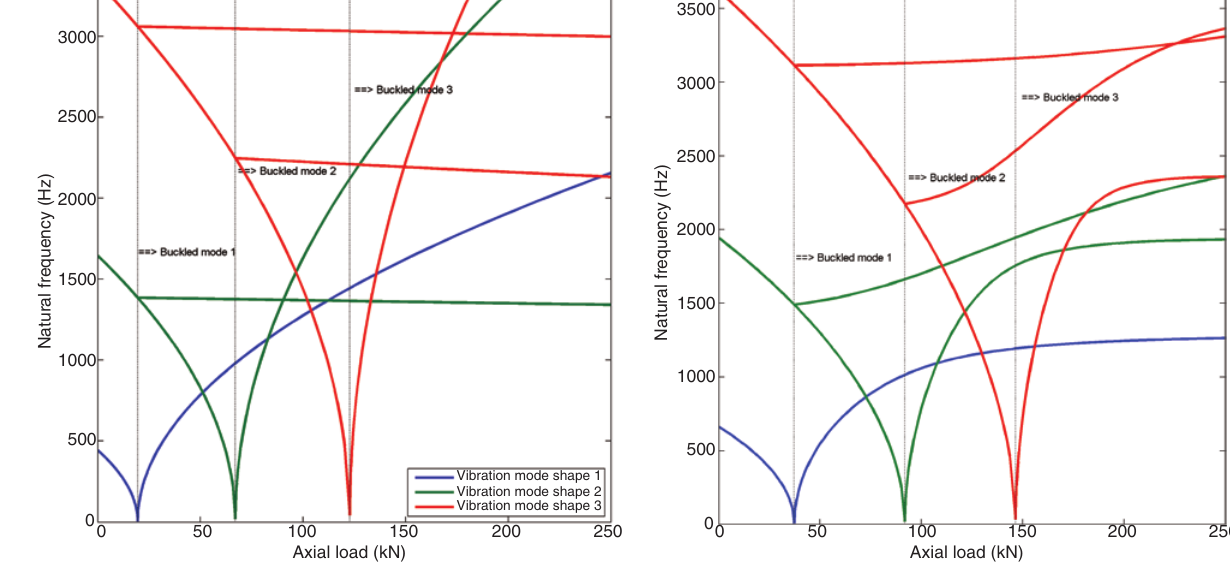
Figure 5 Variation of the natural frequency around the first three buckled configurations with the applied axial load for an SC beam with unidirectional